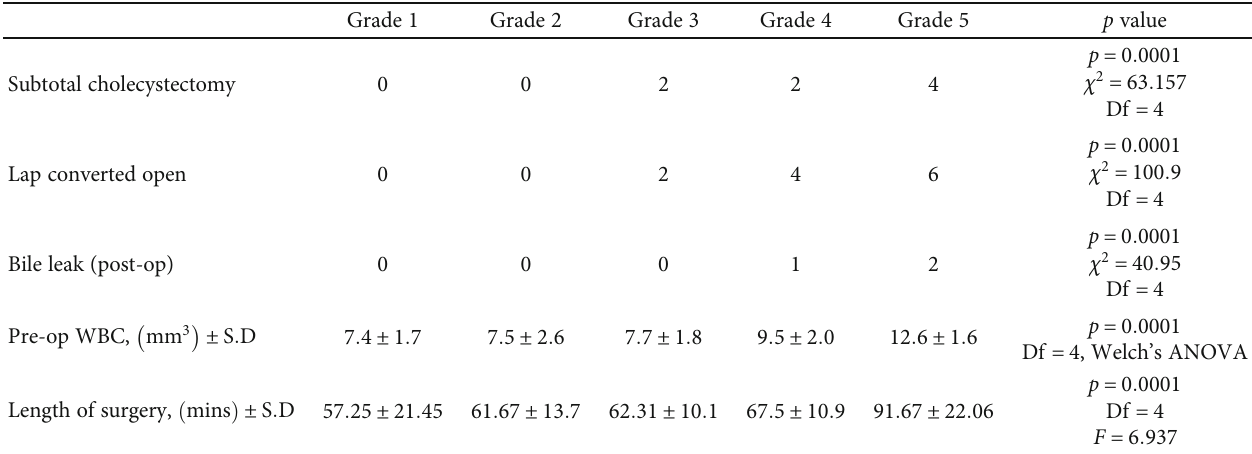
Table 3: Association of perioperative gall bladder grade with other surgical